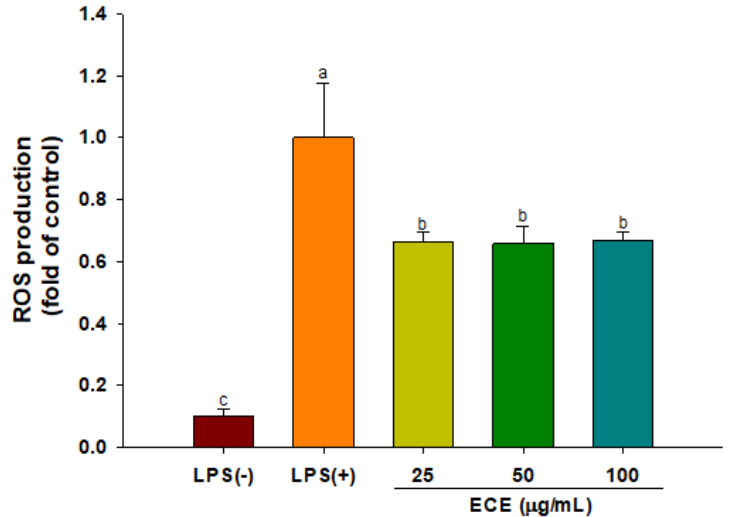
Figure 3. Effect of ECE on ROS production in LPS-stimulated HGF-1 cells. Different letters (a–c) show significant difference ( p < 0.05). ROS: reactive oxygen species; LPS: lipopolysaccharide; HGF: human gingival fibroblasts.